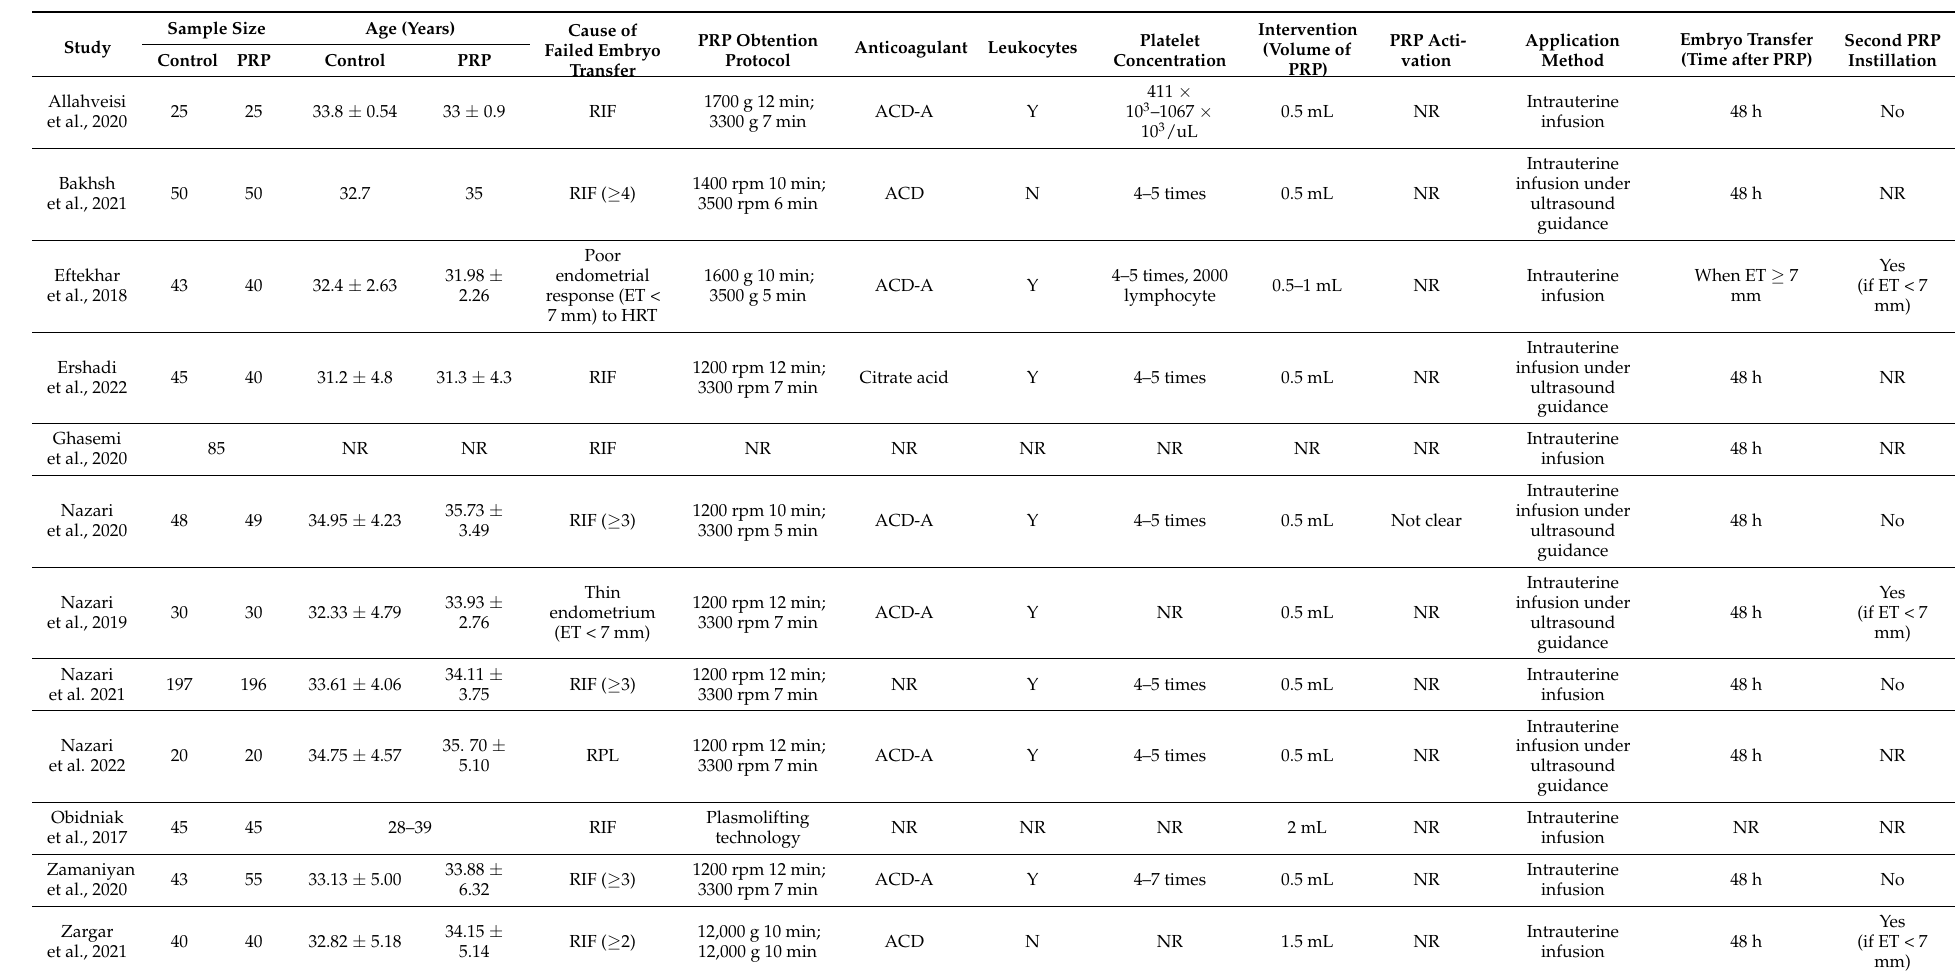
Table 1. Main characteristics of the selected